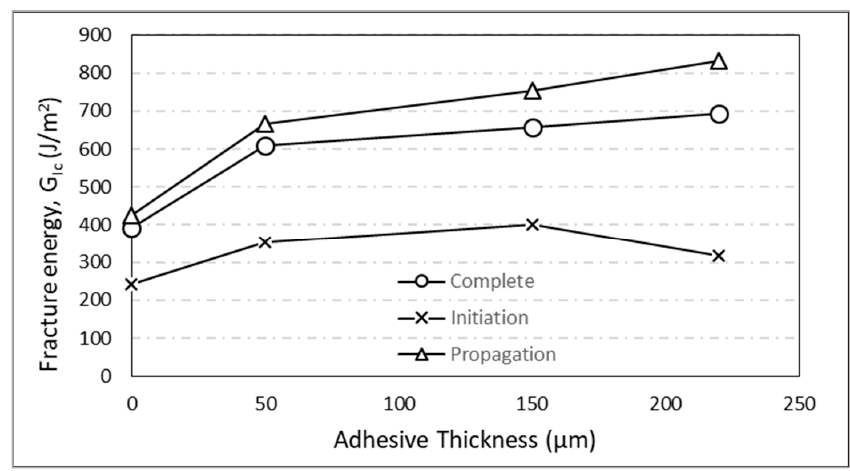
Figure 14. Mode I fracture energy variation with thin film thickness.